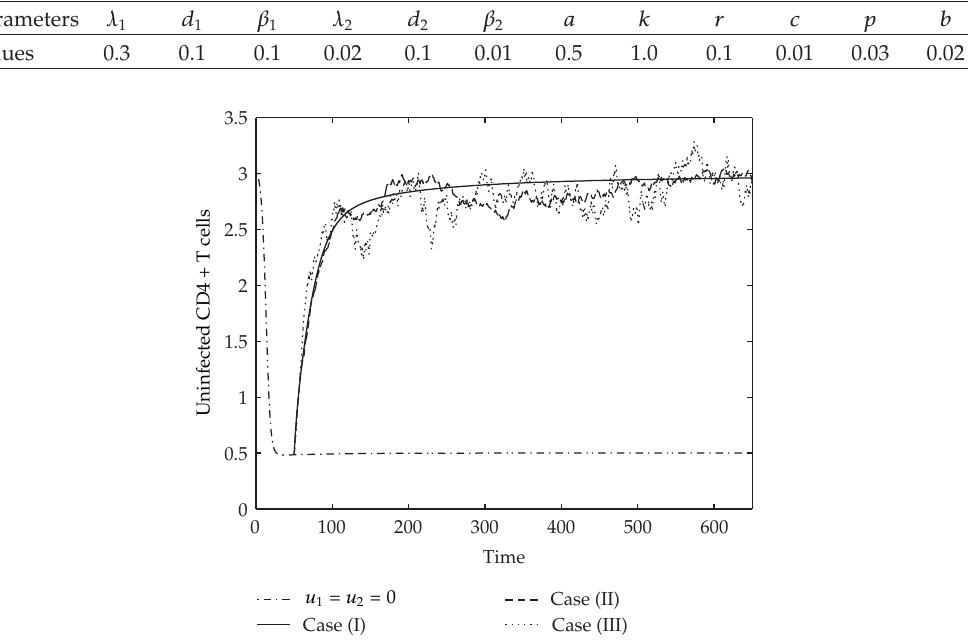
Figure 1: The evolution of uninfected CD4 (cid:4) T